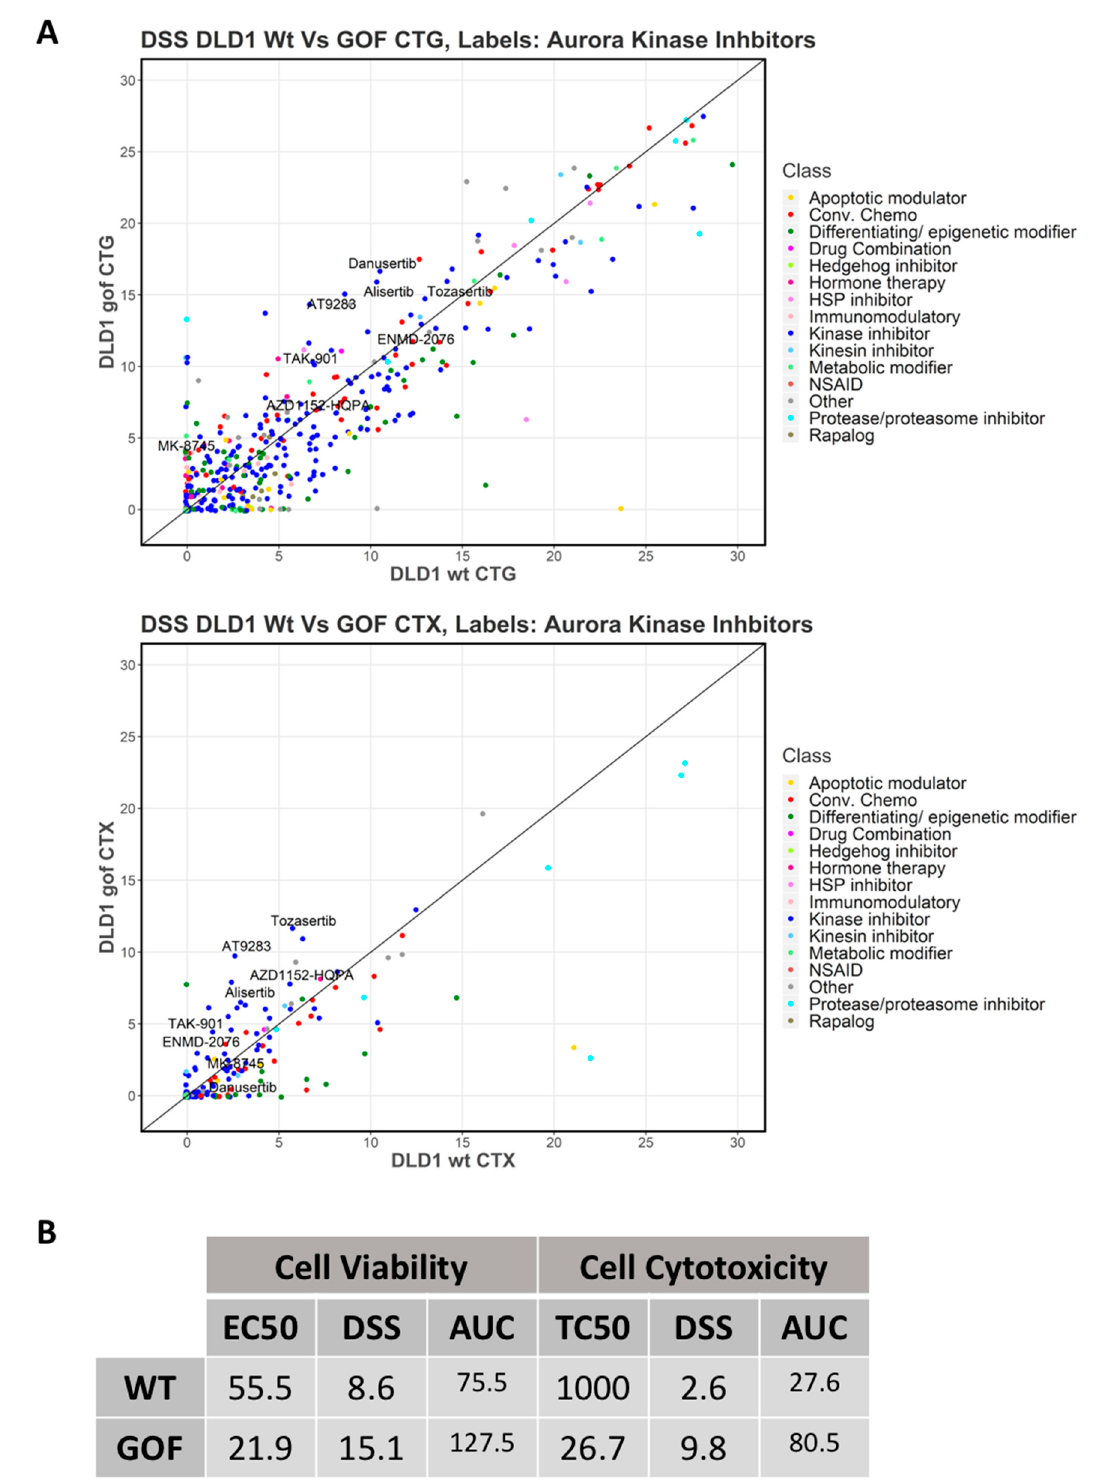
Figure 3. Synthetic lethality drug screening. ( A ) Scatter plots showing the drug sensitivity score (DSS) values of the Aurora kinase inhibitor compounds in the screening panel in DLD1 WT and GOF cells for (upper panel) cell viability (CellTiter-Glo, CTG) and for (lower panel) cell toxicity (CellTox Green, CTX) readouts. Labels show only Aurora kinase inhibitors. ( B ) Key drug response parameters of AT9283 in both WT and NRF2-GOF DLD1 cells are shown. TC 50 (half-maximal toxic concentration), EC 50 (half-maximal e ff ective concentration), AUC (area under the curve) and DSS (drug sensitivity